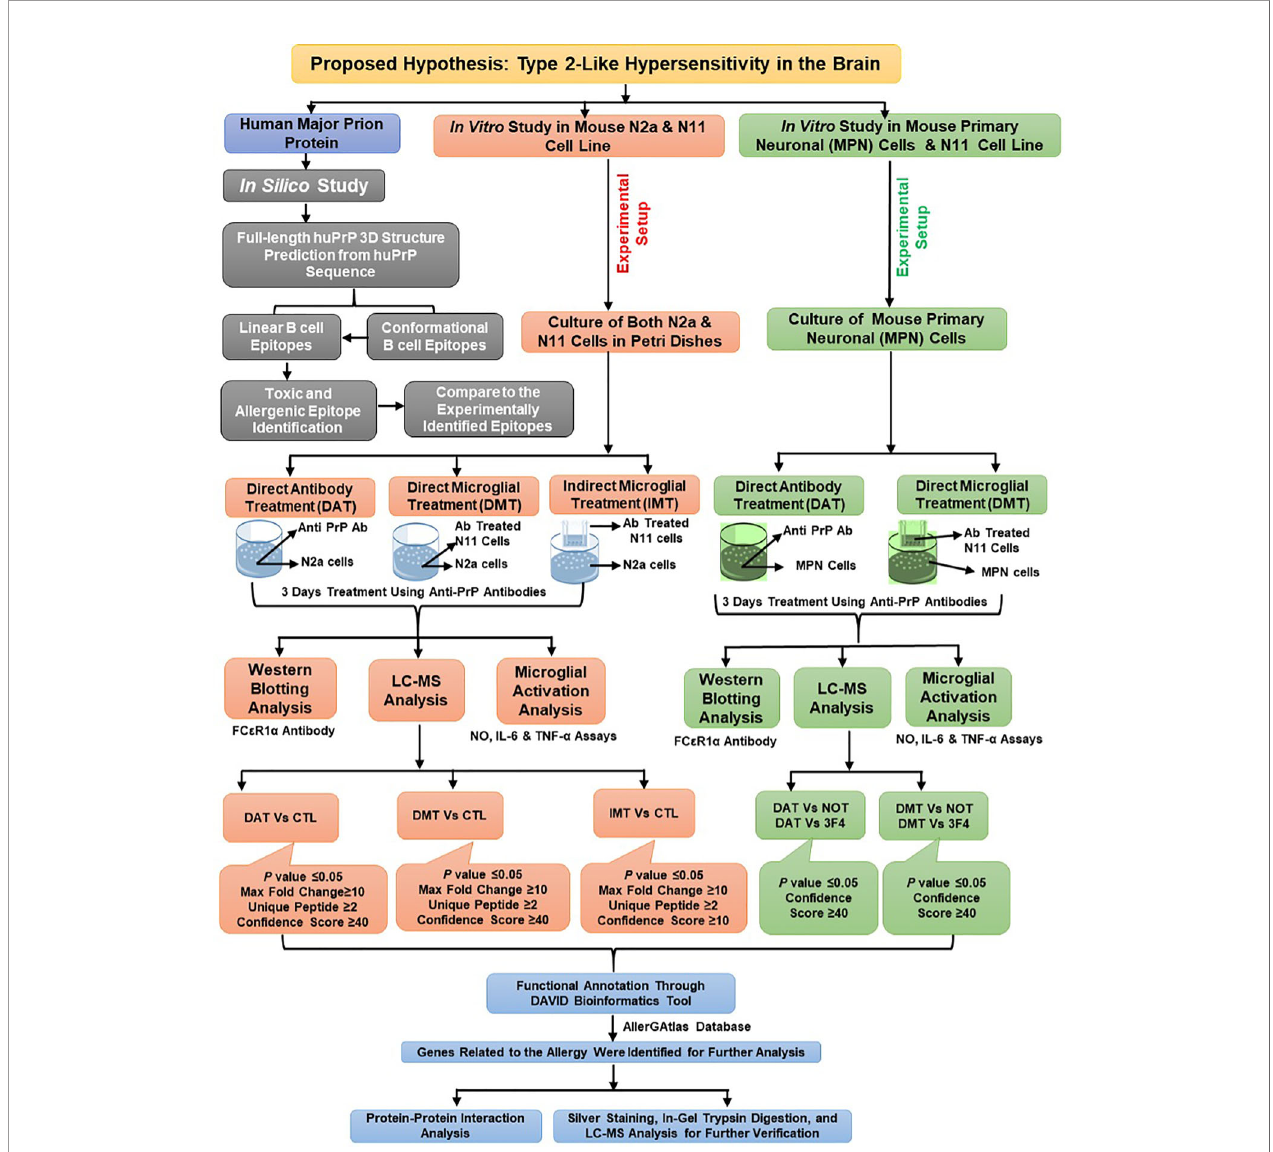
FIGURE 1 | Overall work fl ow of the in silico and in vitro study for the identi fi cation of allergenic proteins following antibody treatment and LC-MS